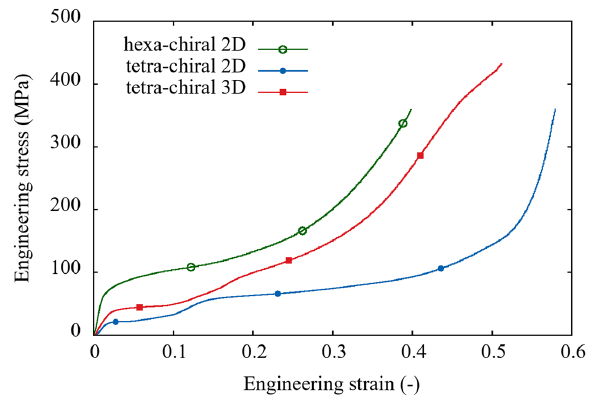
Figure 3. Average quasi-static compression stress-strain curves of hexa-chiral 2D, tetra-chiral 2D and tetra-chiral 3D